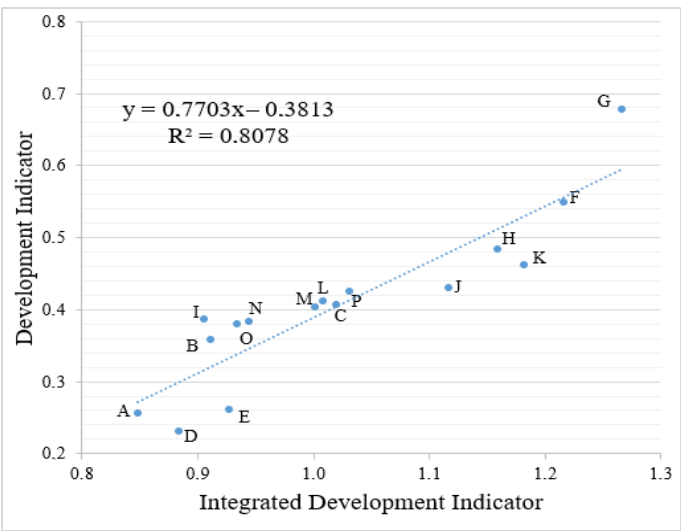
Figure 4. The relation between the level of integrated development and general development of the studied enterprises. Source: Formed by the